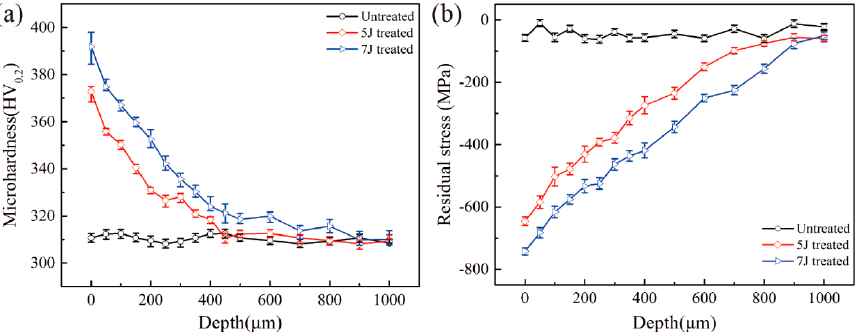
Figure 6. Micro-hardness ( a ) and residual stress distribution ( b ) of the three test samples.